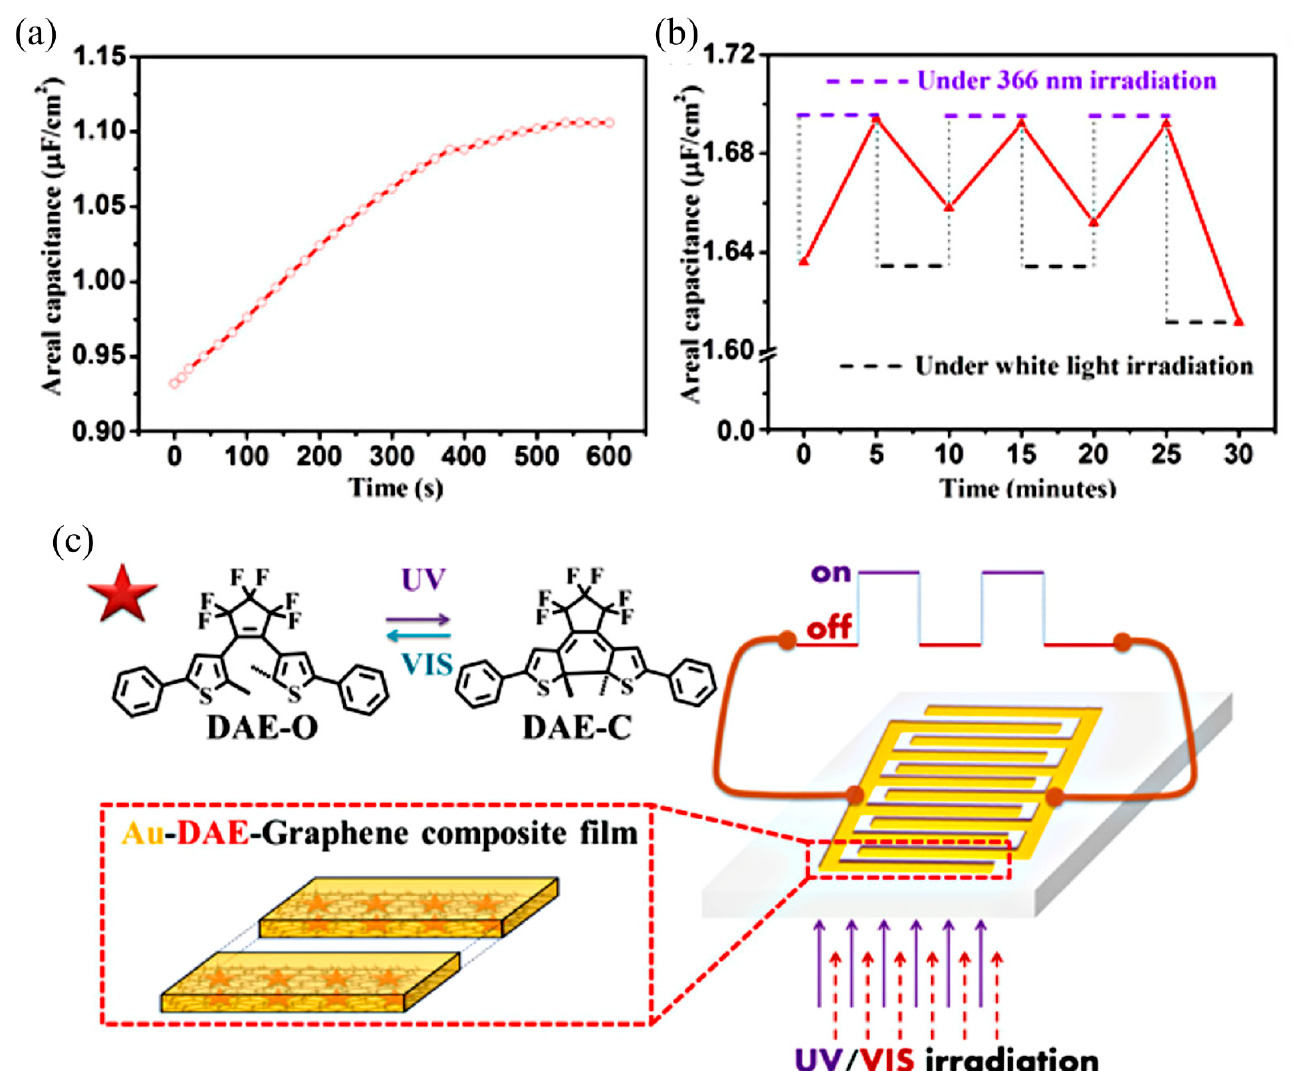
Figure 13. ( a ) Capacitance change of the DAE-graphene microsupercapacitor after different UV irradiation times. ( b ) On-off switching behavior of the DAE-graphene microsupercapacitor by alternating UV (366 nm) and white light (VIS) irradiations for a 5-min interval. ( c ) A schematic illustration of the photo-responsive DAE-graphene microsupercapacitor and its photoisomerization mechanism. Reprinted with permission from ref. [120] Copyright (2017) American Chemical